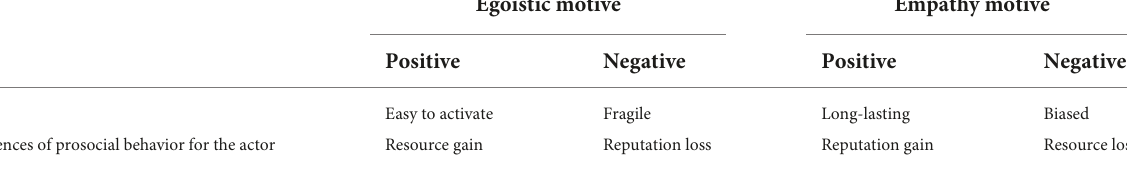
TABLE 1 Summary of positive and negative aspects of egoism and empathy as motives of prosocial